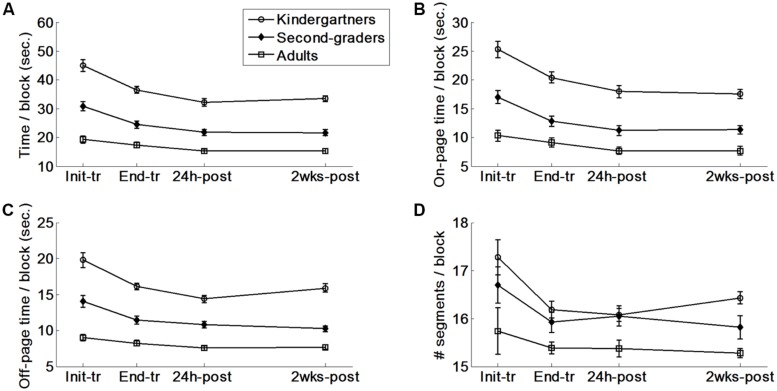
Production data. (A) Overall time. The four points represent the average across the four blocks of the four time points depicted in Figure 2A. (B) On-page time. (C) Off-page time. (D) Number of pen strokes per block. The minimum value is 15 strokes.